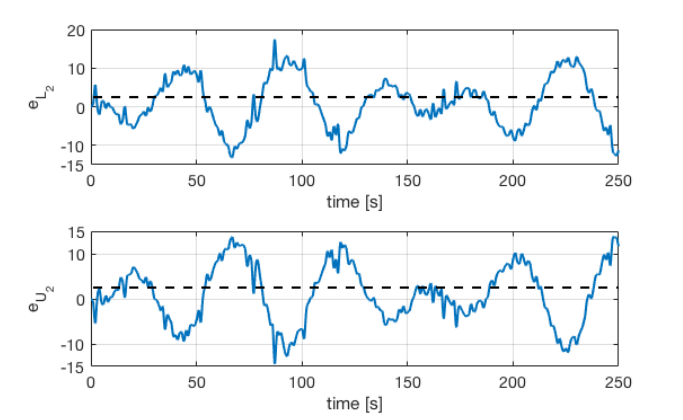
Figure 10. Fault F2 scenario under a random noise, with similar behavior of non-random input case (see Figure 5).